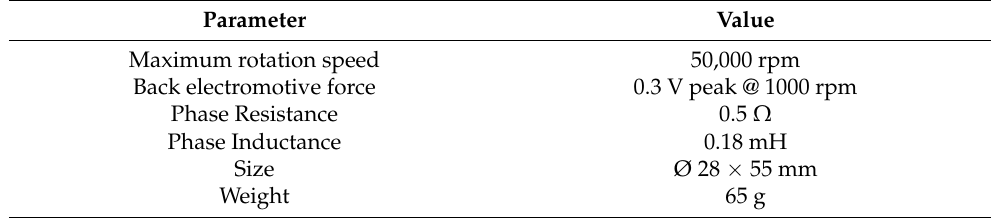
Figure 7. Ultra-high-speed fan motor shape. Table 3. Motor parameter with value.